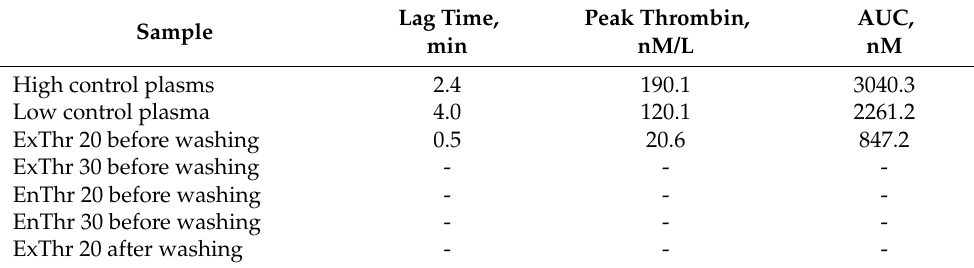
Table 1. Thrombin generation assay of the fibrin matrices before and after